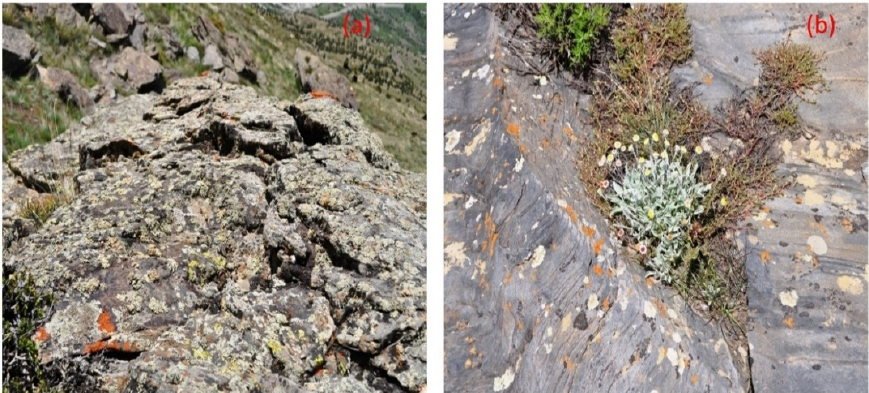
Figure 12. ( a ) Appearance of number of lichen species above tree line indicating suitability of habitat for regeneration, ( b ) Lichen species and herbs invading bare rock above tree